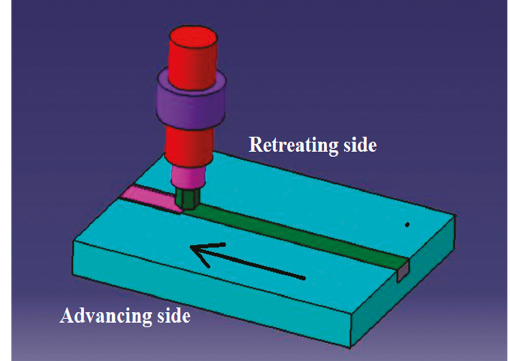
Figure 1: Schematic of FSW